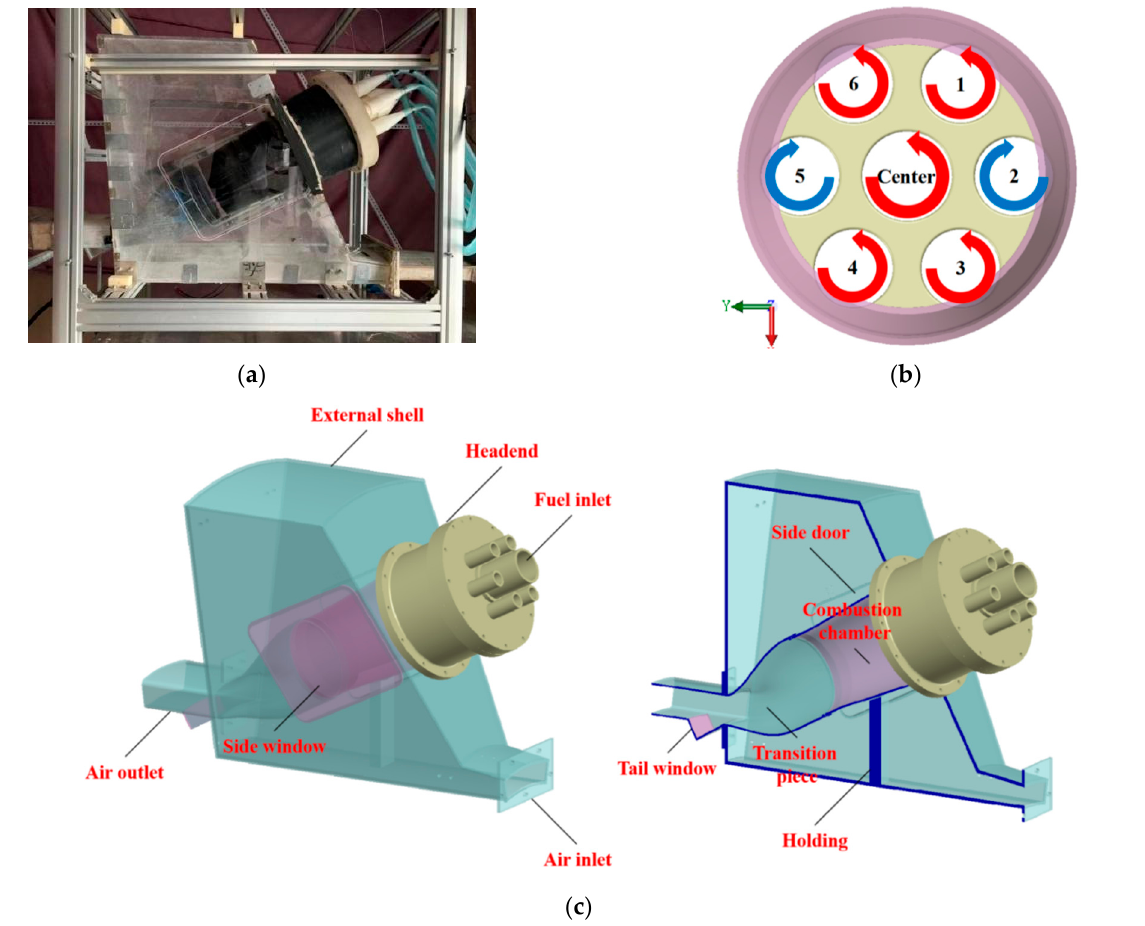
Figure 1. The high-fidelity test model. ( a ) Lateral view of the model; ( b ) Nozzle direction; ( c ) 3-D schematic diagram .